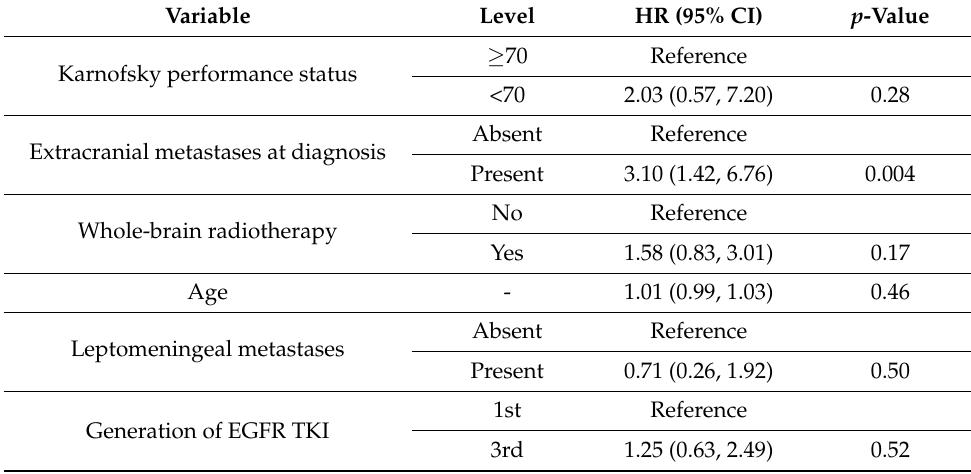
Table 6. Multivariable Cox-Proportional Hazards Modelling of overall survival (OS) for